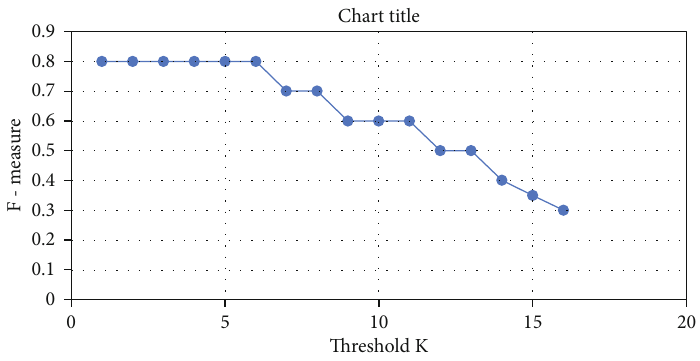
Figure 2: Variation of F -measure under di ff erent matching thresholds.